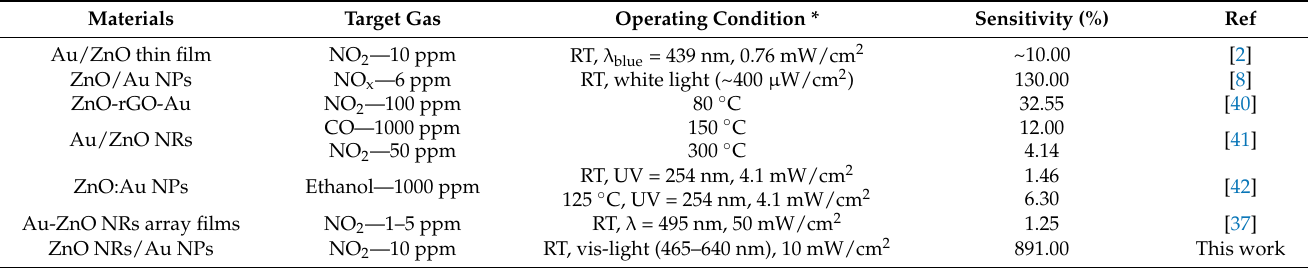
Table 1. The performance comparison ZnO-based gas sensors decorated Au NPs with different operating